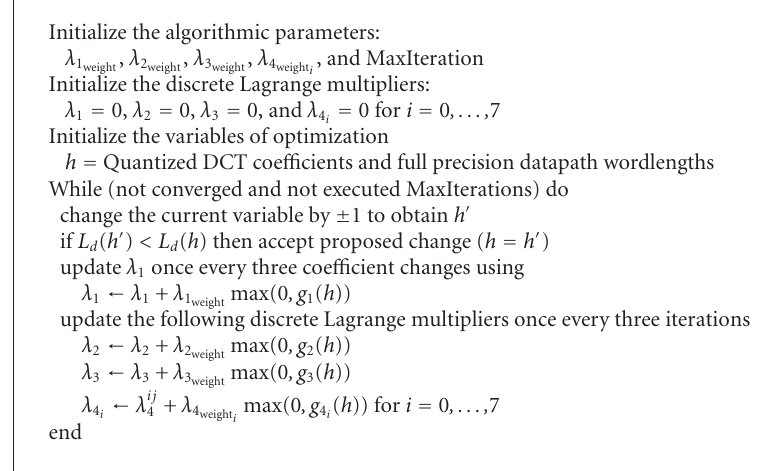
Procedure 1: A local search method for the design of DCT